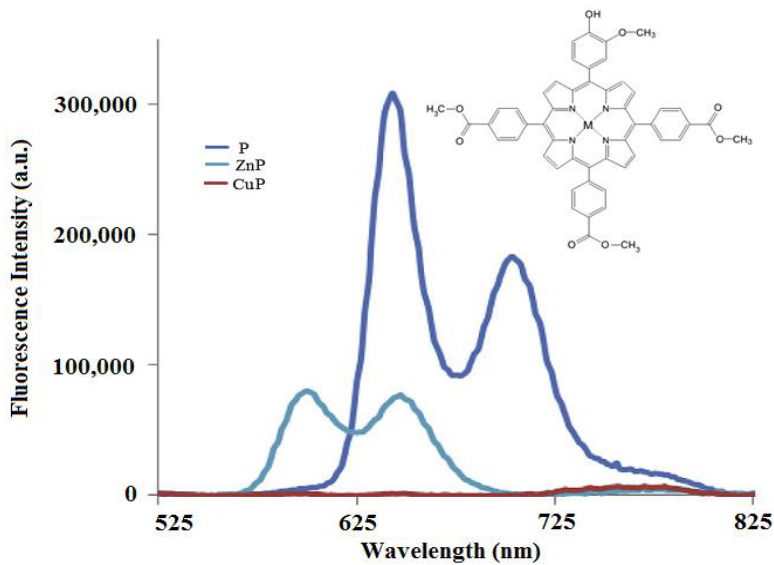
Figure 3. Fluorescence emission spectra for 5-(4-hydroxy-3-methoxyphenyl)-10,15,20-tris(4-carboxymethylphenyl) porphyrin (P), 5-(4-hydroxy-3-methoxyphenyl)-10,15,20-tris(4-carboxymethylphenyl)porphyrinatozinc(II) (ZnP) and 5-(4-hydroxy-3-methoxyphenyl)-10,15,20-tris(4-carboxymethylphenyl)porphyrinatocopper(II) (CuP) (ethanol used as solvent)[23].